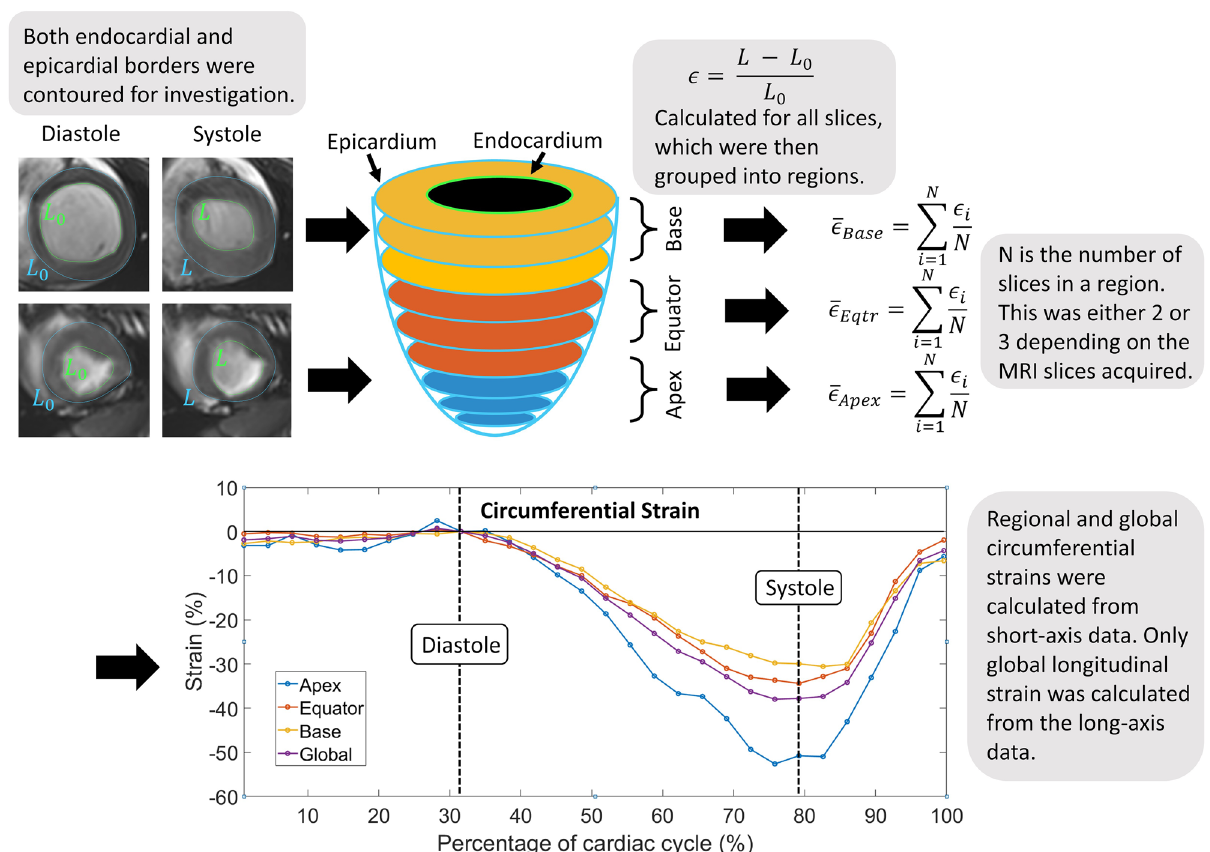
Figure 1. Depiction of workflow from imaging to derived final strains. Short-axis CMRIs with endocardial (green) and epicardial (blue) borders were traced, stacked and grouped into three regions: base, equator/mid, and apex. Strain was calculated for all slices, and the mean was then found by averaging strains in their regions. Finally, the resultant regional and global circumferential strains were found for each time